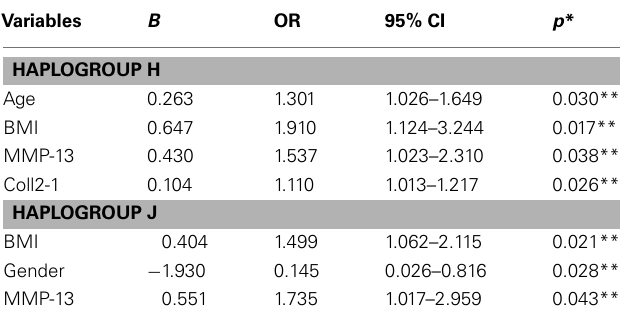
Table 3 | Multivariate logistic regression analysis for diagnosis of osteoarthritis (OA) in haplogroup H and J